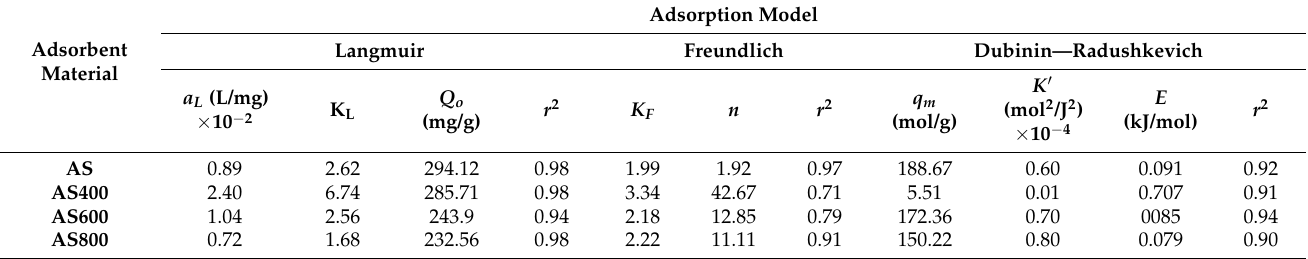
Table 4. Isotherm parameters for organic pollutant adsorption on different alum sludge materials *.